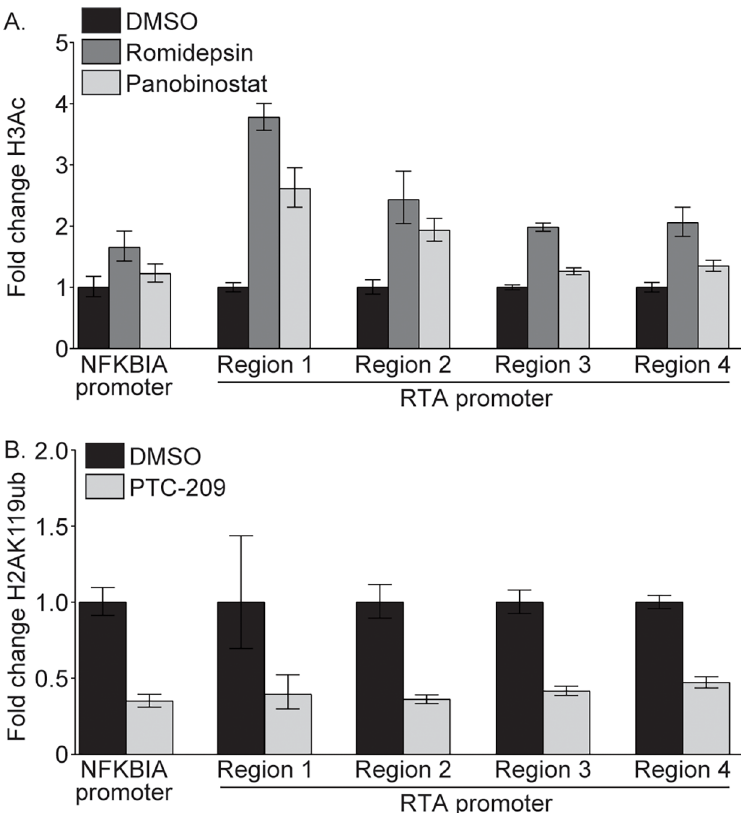
Fig 5. Romidepsin, Panobinostat, and PTC-209 impact histone modifications at the RTA promoter. (A) BCBL-1 cells were treated with DMSO or 1 μ M Romidepsin or Panobinostat for four hours, and levels of H3Ac and total H3 at the RTA promoter were determined by ChIP-qPCR. Levels of H3Ac were normalized to total levels of H3, and the fold difference between DMSO and compound treated cells was calculated. (B) BCBL-1 cells were treated with DMSO or 10 μM PTC-209 for five days, and levels of H2AK119ub and total H2A at the RTA promoter were determined by ChIP-qPCR. Levels of H2AK119ub were normalized to total levels of H2A, and the fold difference between DMSO and PTC-209 treated cells was calculated. Data are representative of three independent